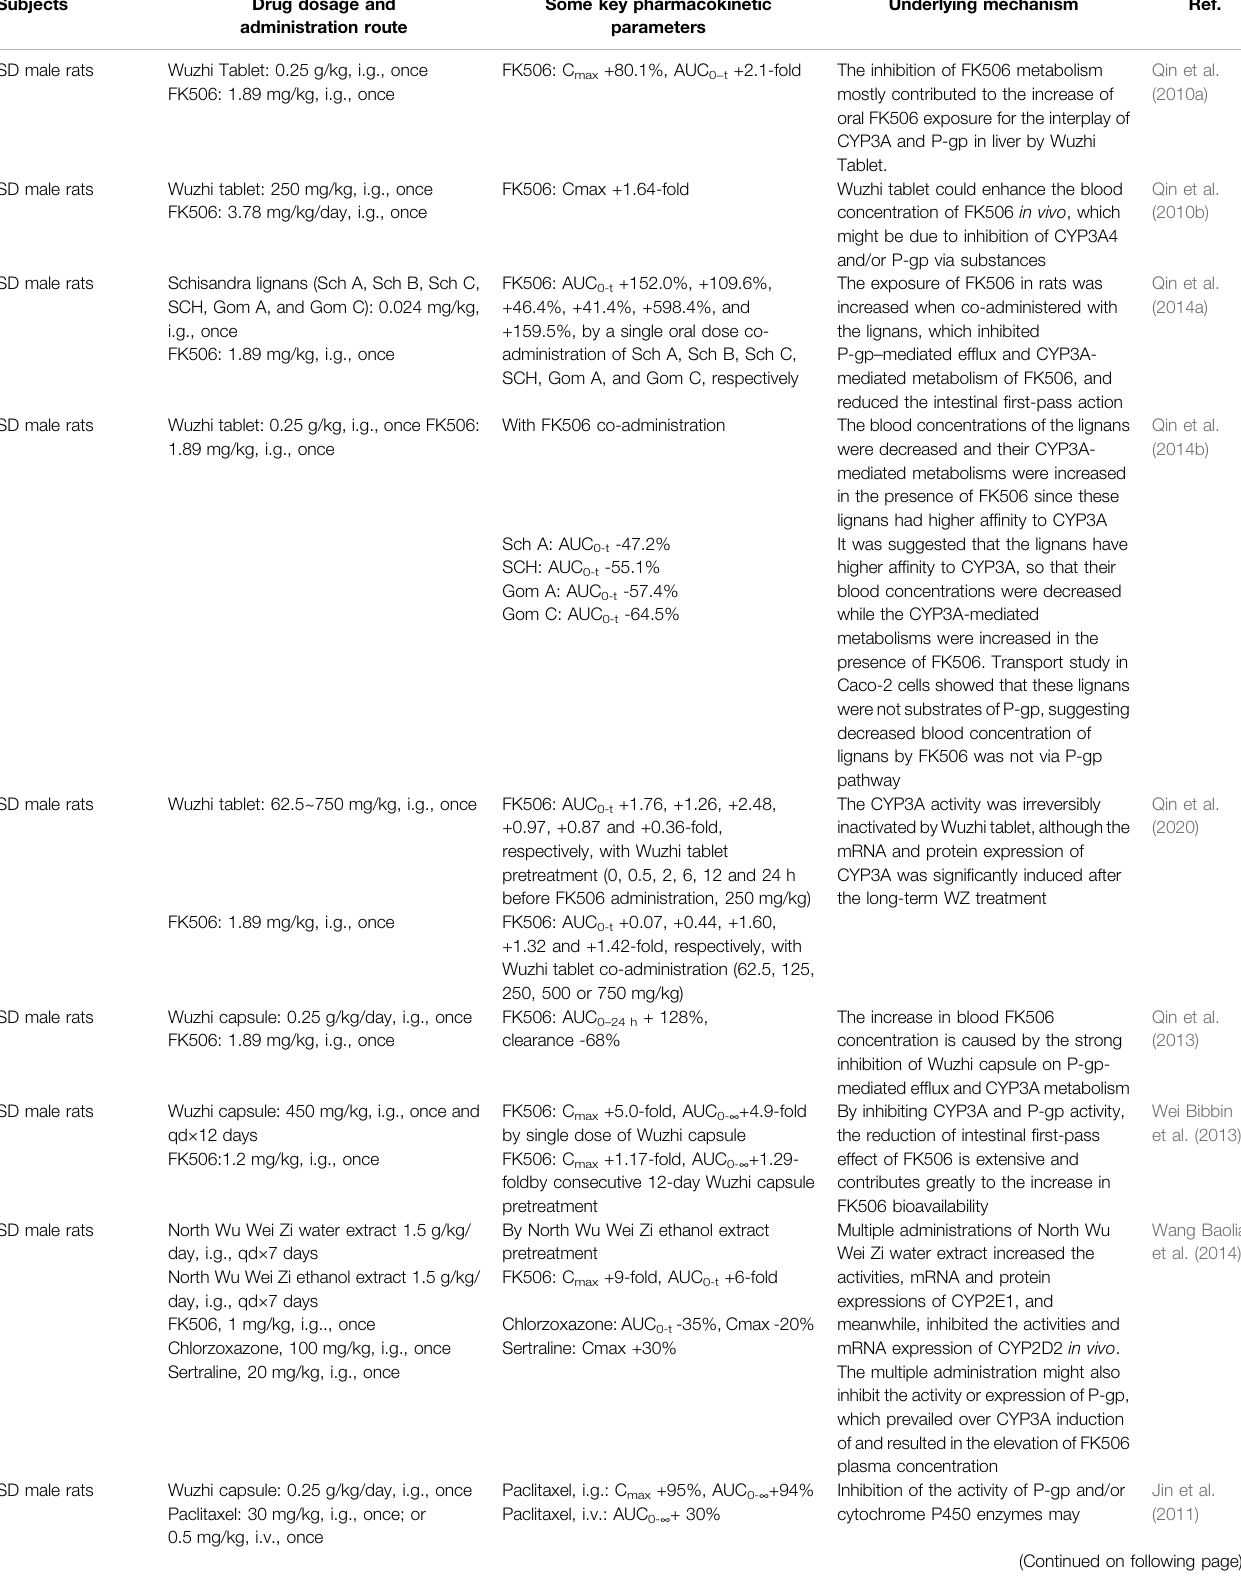
TABLE 5 | Reported DDIs in animal experiments and clinical researches.